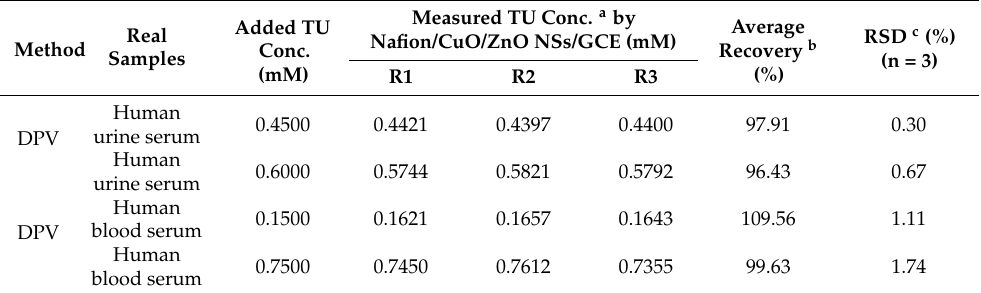
Table 2. Sensor analyses of real biological samples with Nafion/CuO/ZnO NSs/GCE probe by electro-chemical